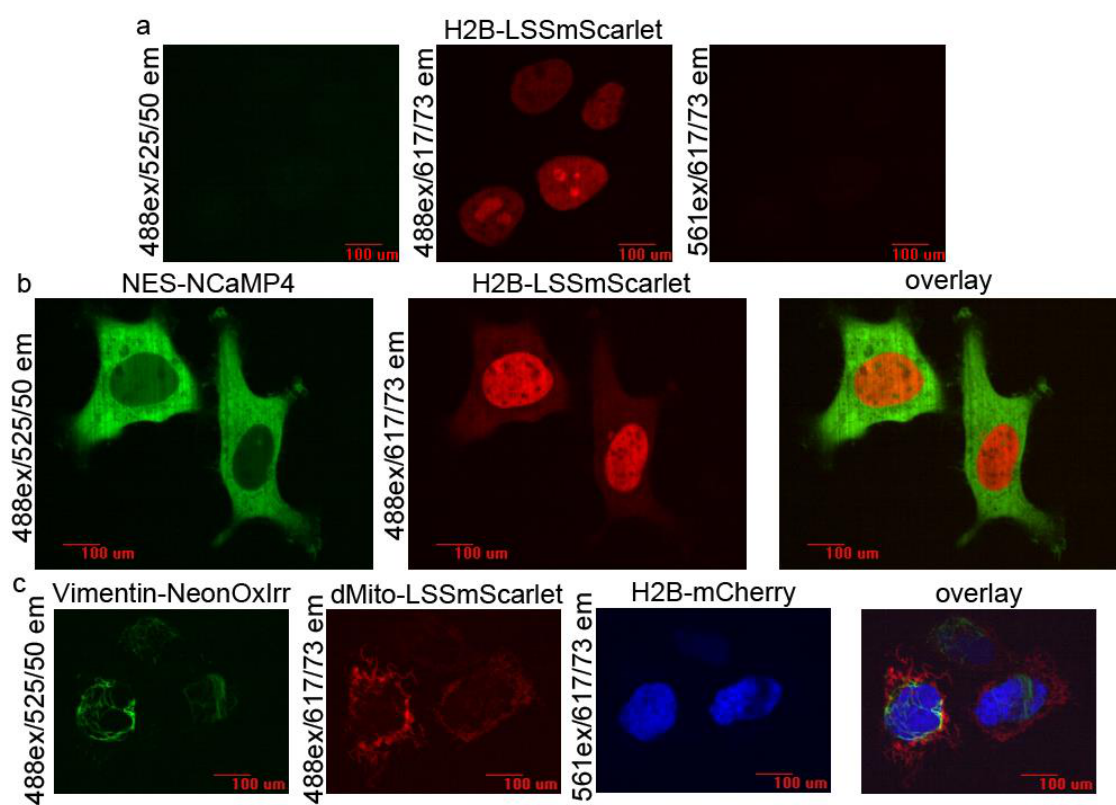
Figure 9. Two- and three-color confocal imaging with LSSmScarlet protein. ( a ) Confocal images of the HeLa cells expressing H2B-LSSmScarlet only in green (488ex/525/50em in green), LSSRed (488ex/617/73em in red) and red (561ex/617/73em in red) channels. We used the same exposure time and brightness/contrast adjustment levels for all channels. We do not see notable bleed-through of the LSSRFP fluorescence into both the green and red channels. ( b ) Two-color confocal imaging of the HeLa cells co-expressing NES (nuclear export signal)-NCaMP4 green calcium indicator and H2B-LSSmScarlet fusion LSSRFP in green (488ex/525/50em in green), LSSRed (488ex/617/73em in red) and overlayed channels using single- excitation with 488nm laser. ( c ) Three-color confocal imaging of the HeLa cells co-expressing the Vimentin-NeonOxIrr fusion green indicator for hydrogen peroxide, dMito-LSSmScarlet fusion LSSRFP and H2B-mCherry fusion RFP in green (488ex/525/50em in green), LSSRed (488ex/617/73em in red), red (561ex/617/73em in blue) and overlaid channels. Scale bar, 100 µM.